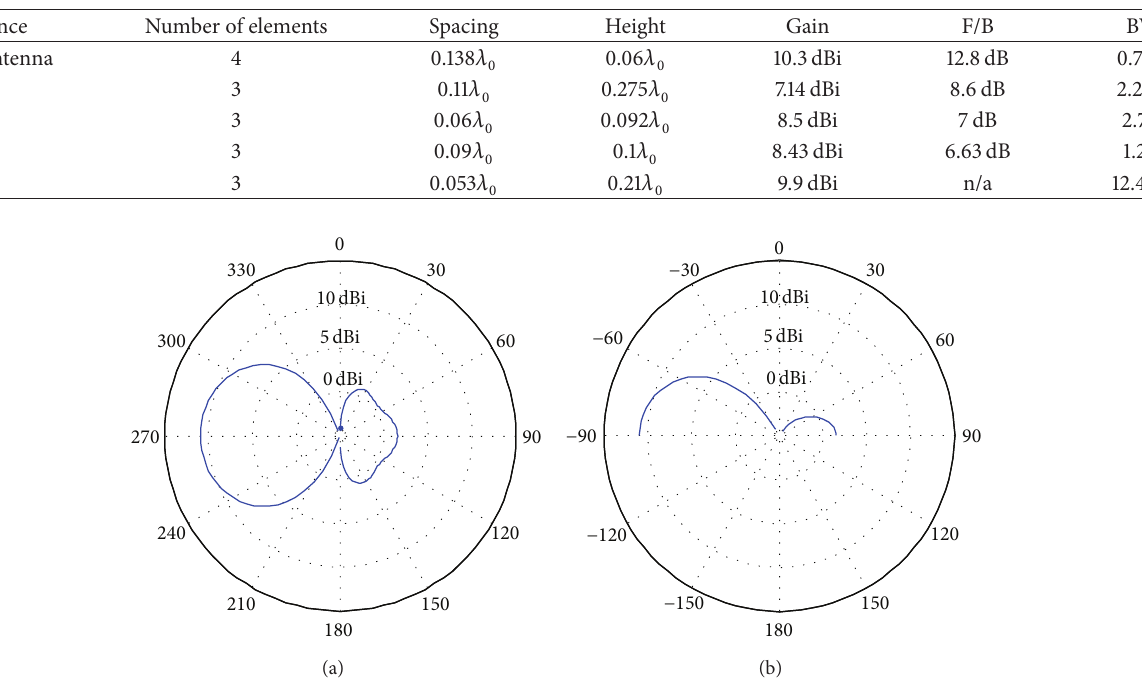
Figure 12: Simulated radiation patterns at 400 MHz: (a) azimuth plane and (b) elevation